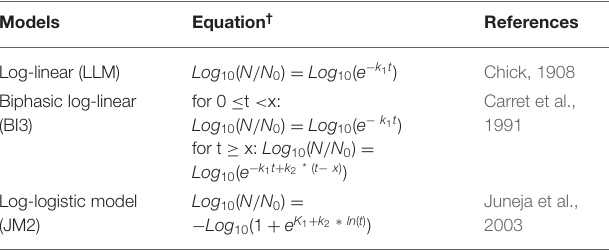
TABLE 3 | Descriptions of the equation parameters, BIC values, predicted T 90 , and T 99 values (days) calculated from the best-fit and log-linear models that evaluated the persistence of the cell equivalents of E. coli (EC) and enterococci (ENT) measured from microcosms containing sewage spiked river water stored at 4 ◦ C for up to 337